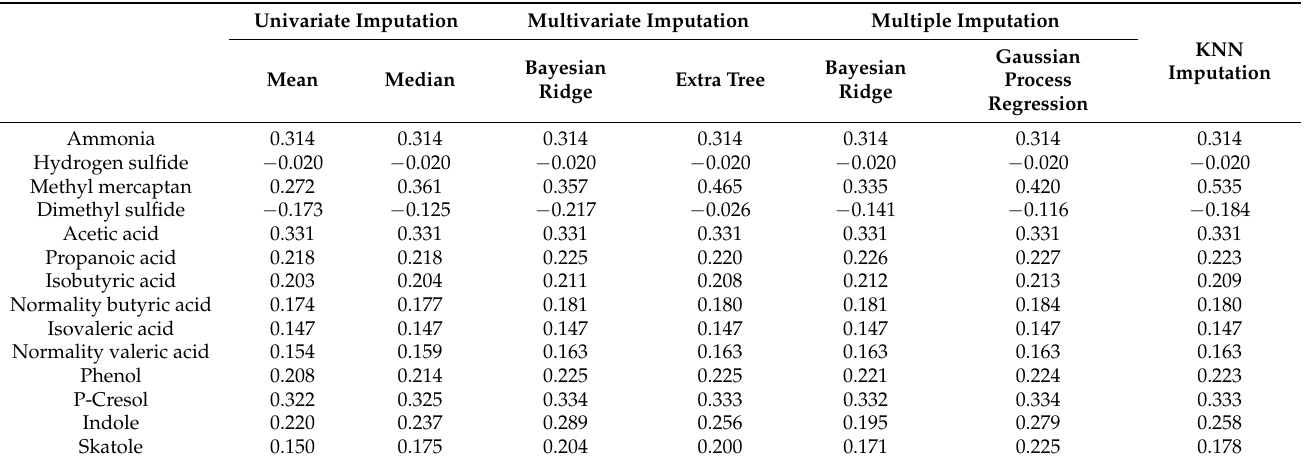
Figure 9. Heatmap complete data by best imputation method. ( left ) Heatmap of data using multi- variate imputation using Bayesian ridge. ( right ) Heatmap of data using KNN imputation. Table 6. Correlation results by imputation